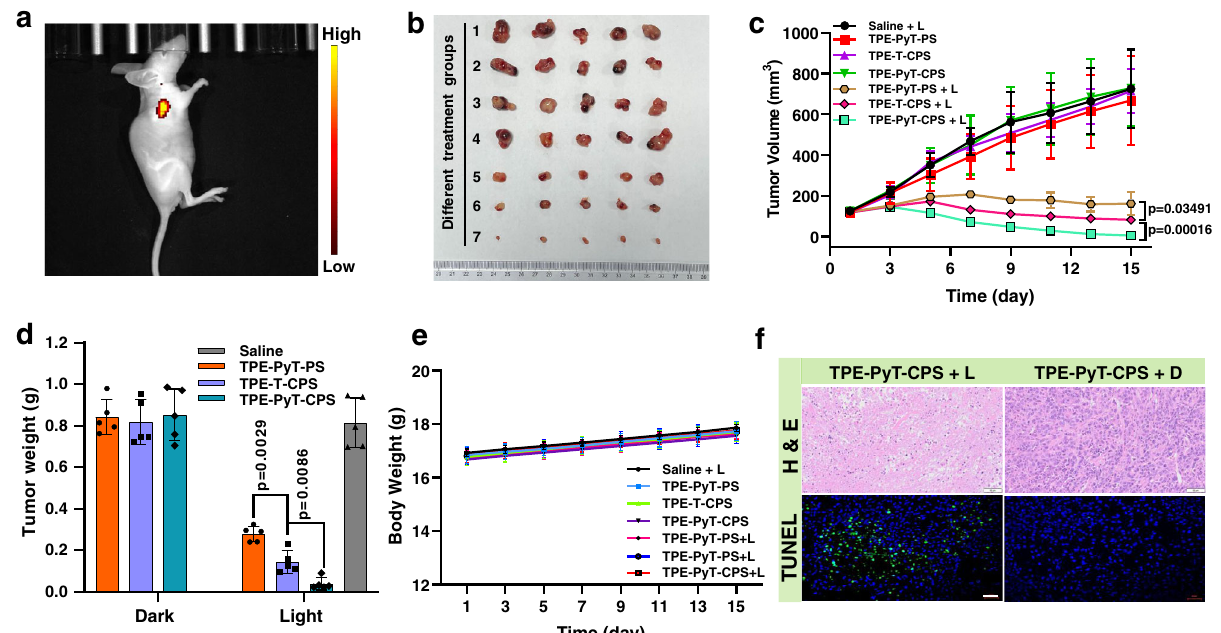
Fig. 10 Therapeutic effect of different AIEgens in vivo. ( a ) Fluorescent image of mice after intratumoral injection of TPE-PyT-CPS (0.1 mM, 120 μ L) for 18 h. ( b ) Photographs of excised tumors on the 15th day in different groups (1. saline + L, 2.TPE-PyT-PS, 3.TPE-T-CPS, 4.TPE-PyT-CPS, 5.TPE-PyT-PS + L, 6.TPE-T-CPS + L, 7.TPE-PyT-CPS + L). ( c ) Changes of tumor volume and weight ( d ) during PDT that treated with different AIEgens (0.2 mM, 100 μ L in saline) as the PS under 532 nm laser irradiation of 35 mW cm − 2 for 5 min ( n = 5 animals). ( e ) Body weight curves of mice during PDT treatment in different treating groups ( n = 5 animals). ( f ) H&E staining (scale bar: 50 μ m) and apoptotic analysis of TUNEL staining (scale bar: 20 μ m) images of tumor slices from mice after treatment with saline and TPE-PyT-CPS under 532 laser irradiations. The experiments in 10a and 10 f were performed from biologically independent animals ( n = 3), representative images are shown. Data in 10c, d, e are presented as mean ± SD ( n = 5 animals). Statistically signi fi cant differences between the experimental groups were analyzed by two-tailed Student ’ s t-test. when p < 0.05, it was considered to have statistical signi fi cance. Source data are provided as a Source Data fi